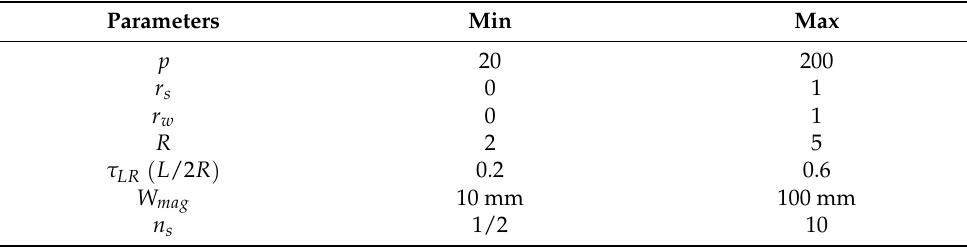
Table 3. Optimization